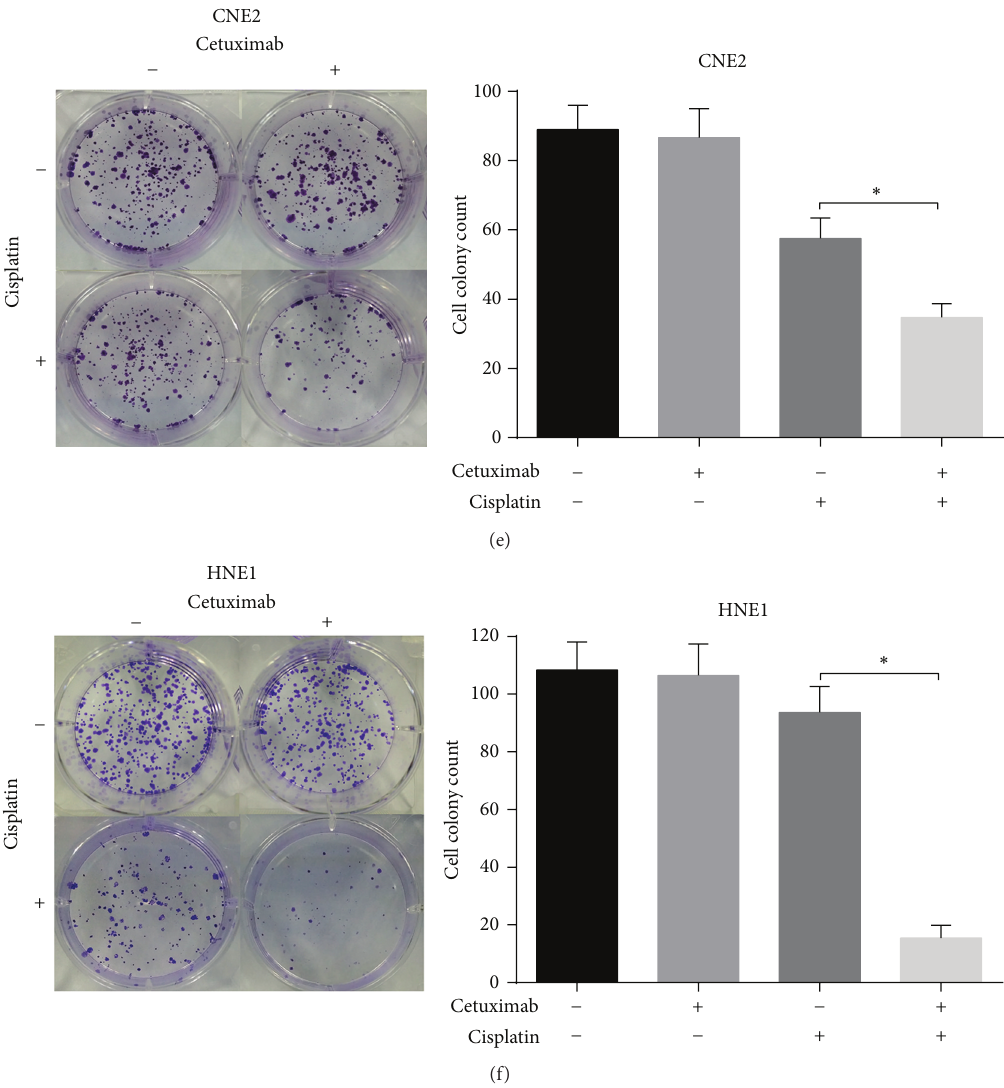
Figure 2: Cetuximab enhanced cisplatin-induced apoptosis and antiproliferation effect in HNE1 cells. HNE1 cells were treated with cetuximab, cisplatin, or the double agents for 48 h before the cells were analysed by flow cytometry ((a), (b), (c), and (d)). Multiplication capacity of cells in different treatment groups is shown in ((e), (f)) via a colony formation assay. ∗ 𝑝 < 0.05 versus cisplatin treatment alone.